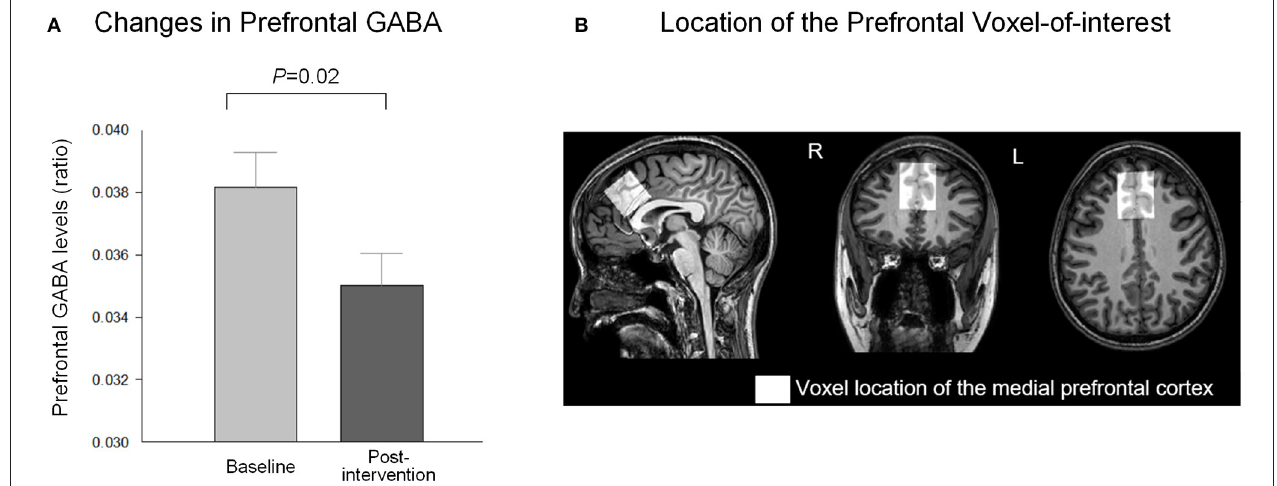
FIGURE 1 | Changes in prefrontal GABA levels after the relaxation training. (A) Prefrontal GABA level decreased ( t = 2.53, P = 0.02) following 10 daily sessions of the computerized relaxation training. (B) The location of the prefrontal region as voxel-of-interest of the study (3 × 3 × 3 cm 3 ) is overlaid on the T1-weighted image of a representative study participant. GABA, gamma-aminobutyric